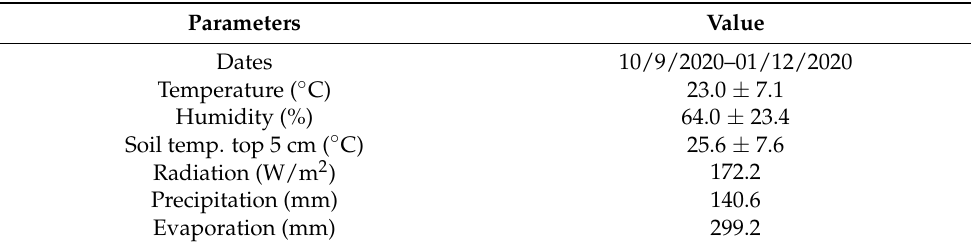
Table 2. Meteorological data for the 2020 field experiments 1